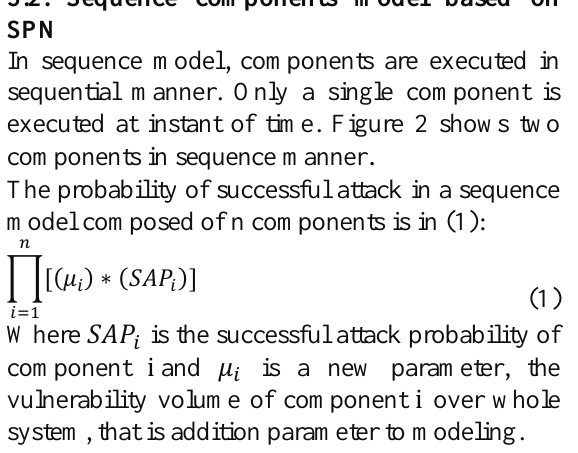
Figure 3. Parallel components model based on